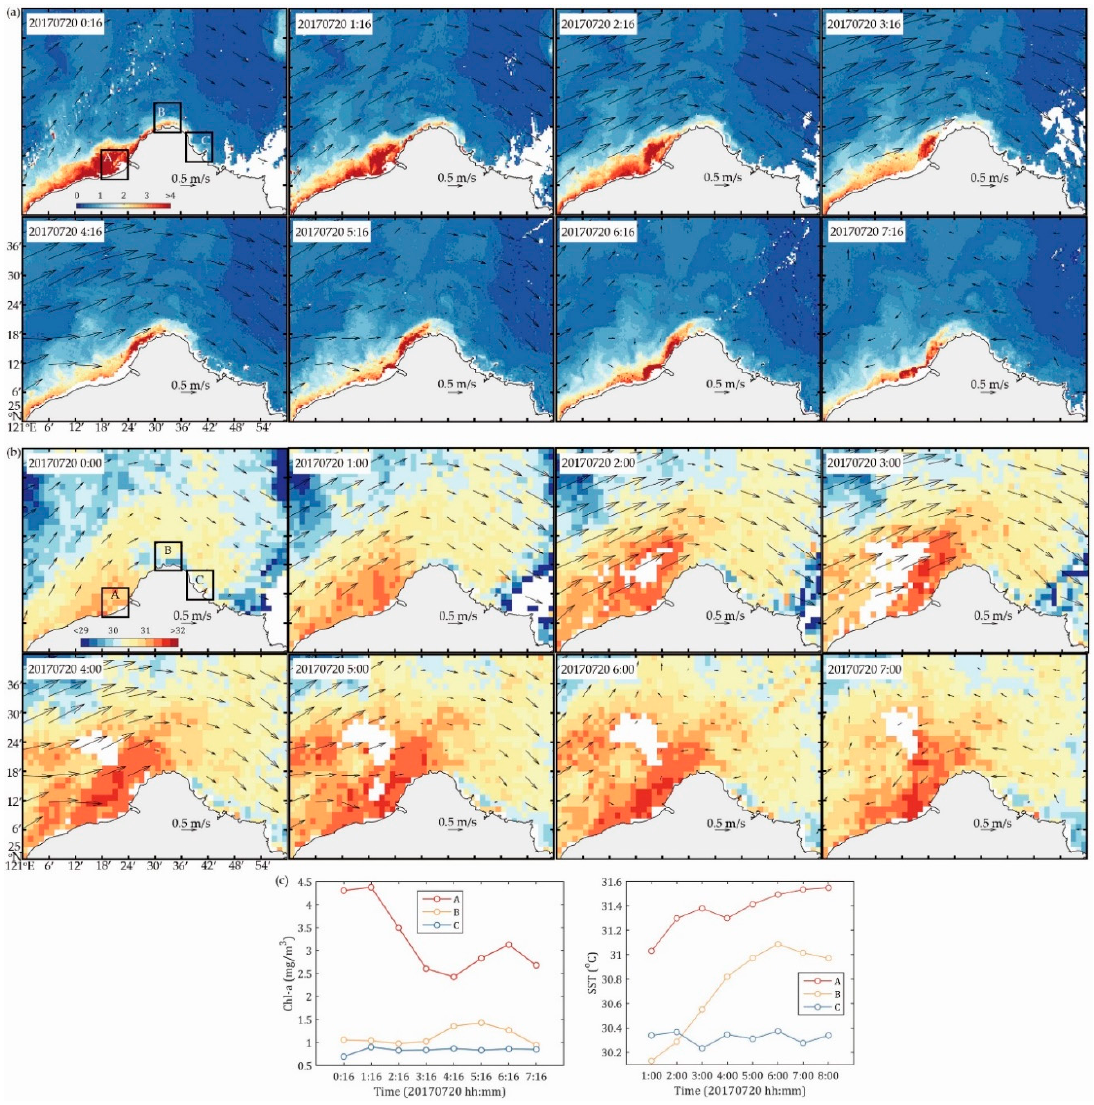
Figure 15. Short time period of ( a ) chlorophyll concentration and ( b ) sea surface temperature (SST) variations with ocean currents from July 20, 2017, 0:00 to 7:00 (UTC). The areas A, B, and C in the ( c ) time series diagram were selected as black boxes inside the map.